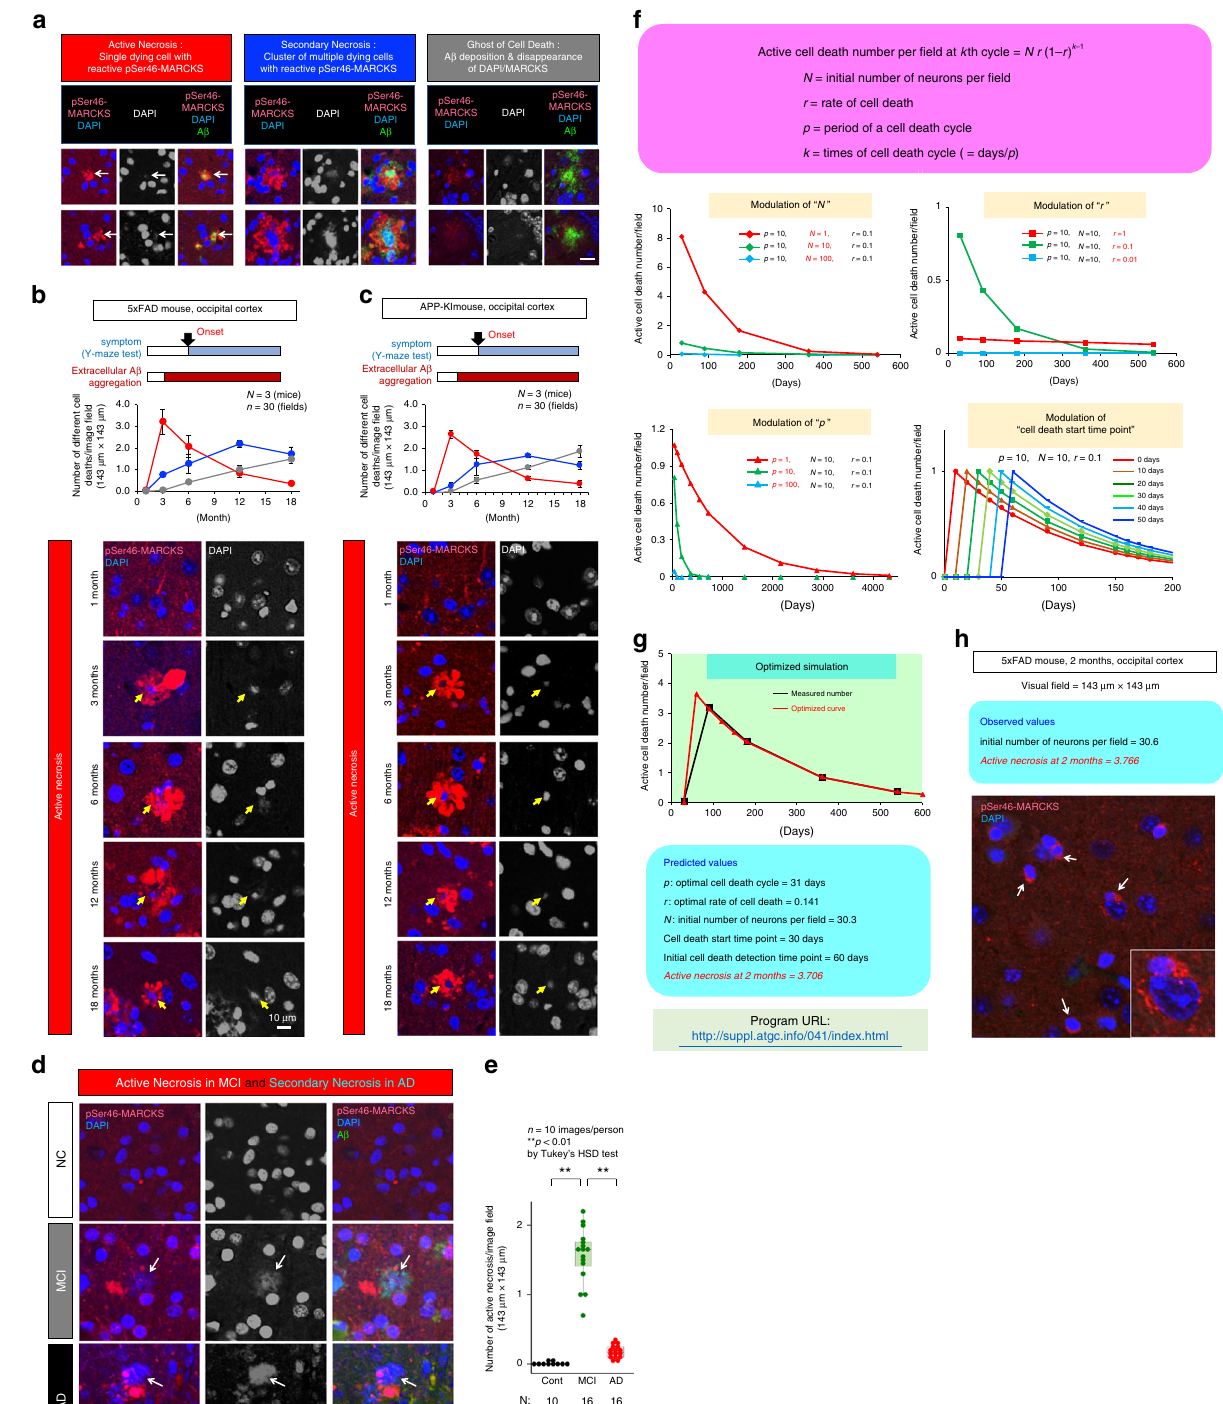
brains of MCI and non-neurological disease control patients con fi rmed that cortical neurons underwent morphologically similar necrosis in MCI patient brains (Fig. 2d). The active necrosis revealed by pSer46-MARCKS were present at signi fi - cantly higher frequencies in all MCI patients than in AD patients (Fig. 2d, e), and neurons surrounded with reactive pSer46- MARCKS, even though they did not match the strict criteria